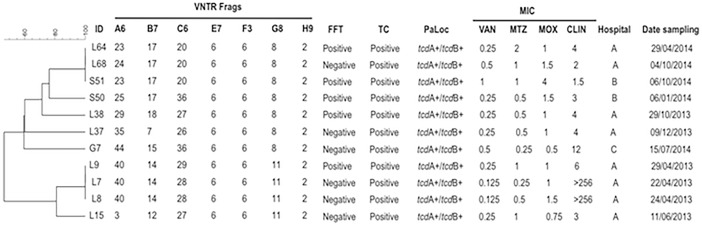
Analysis of ribotype 002 by MLVA.MLVA was applied to 11 isolates belonging to the ribotype 002. Dendrogram showing similarities of banding patterns generated with high-resolution capillary gel-based electrophoresis (CE)-PCR. MLVA clusters are identified by minimum-spanning tree: one clonal complex is defined by MLVA type with less than a two-locus difference. In addition, free fecal toxin A/B (FFT), toxin in cell culture (TC), presence of PaLoc genes (tcdA/tcdB), minimal inhibitory concentrations (MIC) for vancomycin (VAN), metronidazole (MTZ), moxifloxacin (MOX) and clindamycin (CLIN) are shown for each isolate with the respective breakpoints. VNTR, variable-number tandem repeat.